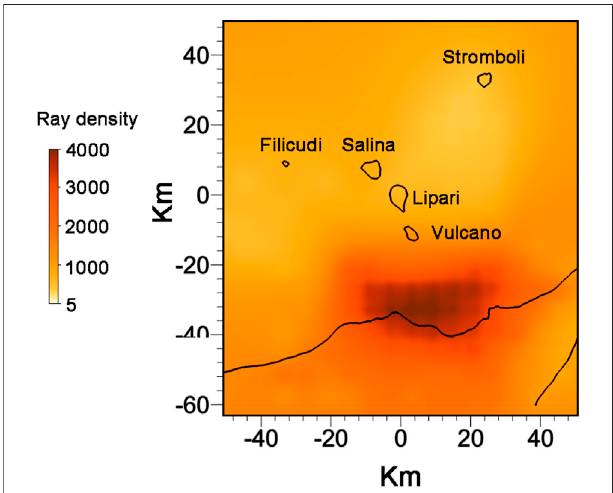
FIGURE 4 | Representation of the set of ray paths used in the present work. Blue triangles represent the positions of seismic stations. Red crosses are the locations of the air-gun shots generated during the TOMO-ETNA